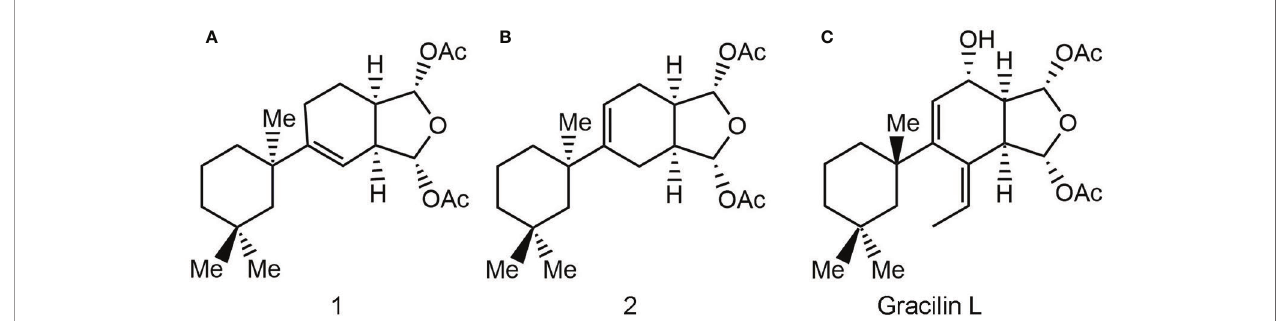
FIGURE 1 | Natural gracilin and two synthetic analogues structures. Compound 1 (A) , 2 (B) , and Gracilin L (C) .